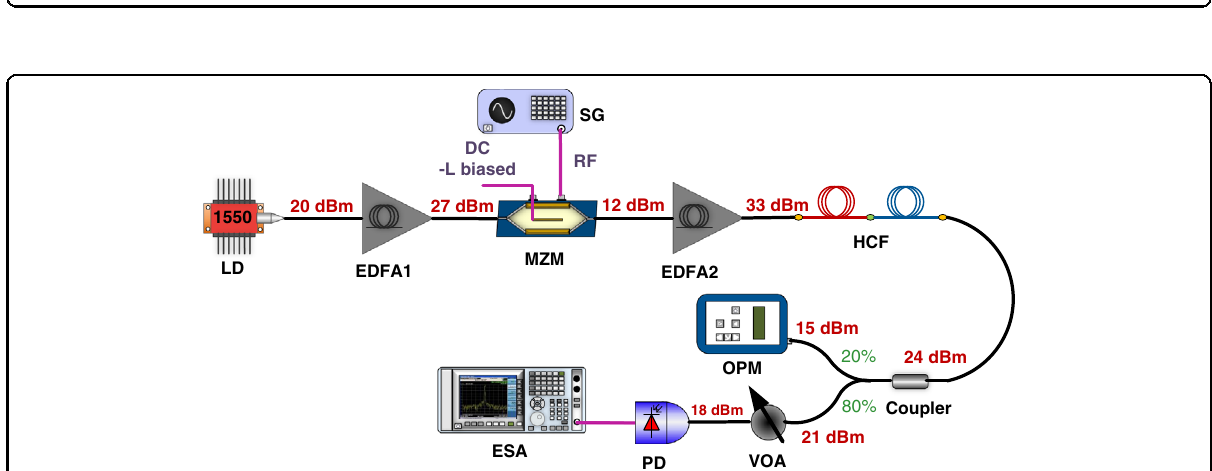
Fig. 5 Noise fi gure optimized HCF APL set-up. The MZM was L-biased and two EDFAs were used to keep the optical power as high as possible (limited by the power handling of the MZM used (500 mW maximum input) along the link, minimizing degradation due to shot noise. LD, laser diode; EDFA, erbium-doped fi bre ampli fi er; MZM, Mach-Zehnder modulator; SG, signal generator; VOA, variable optical attenuator; OPM, optical power metre; PD, photodiode; ESA, electrical spectrum analyzer. Details of the speci fi c components used are given in the ‘ Methods ’ section